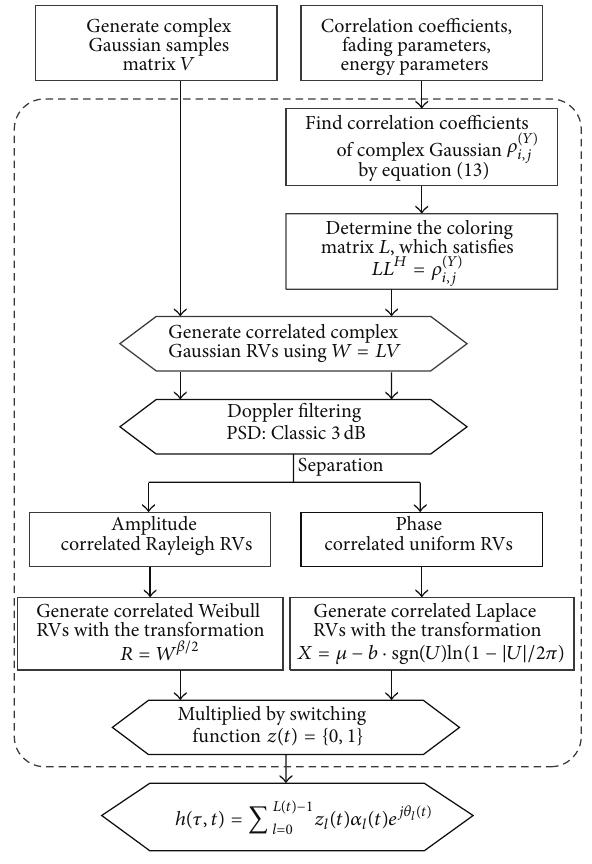
Figure 2: Generating correlated complex gaussian RVs.